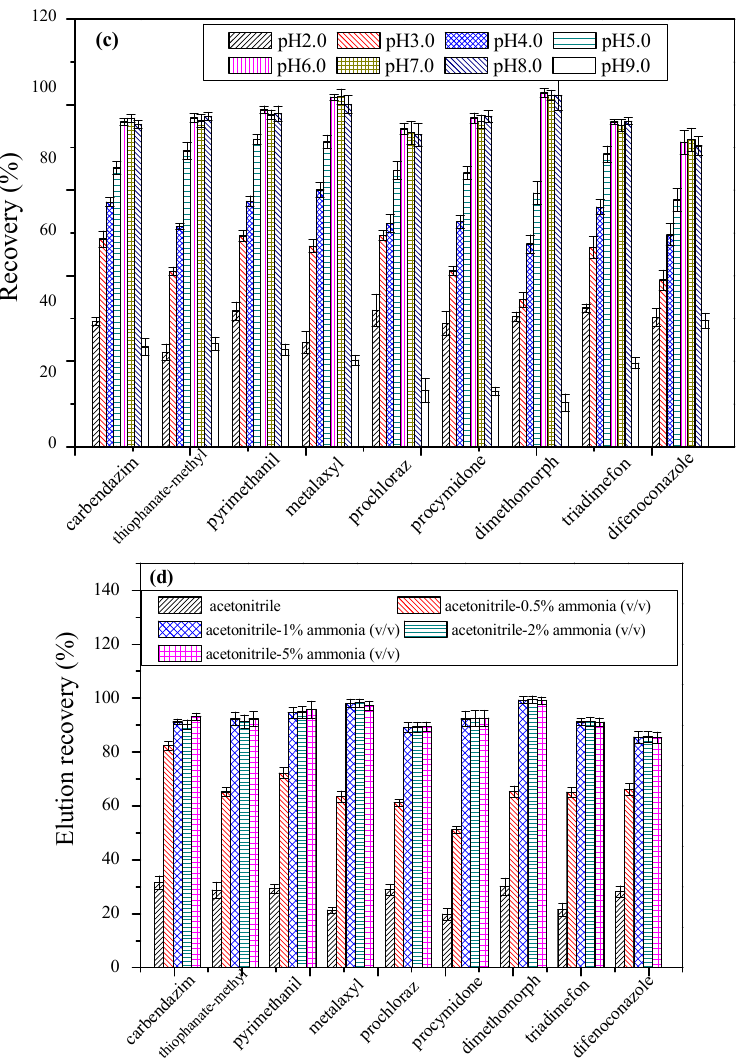
Figure 4. Extraction and desorption parameter optimization; each experiment was performed in sextuplicates: ( a ) extraction solvent; ( b ) adsorbent usage amount; ( c ) pH effect; ( d ) desorption solvent.